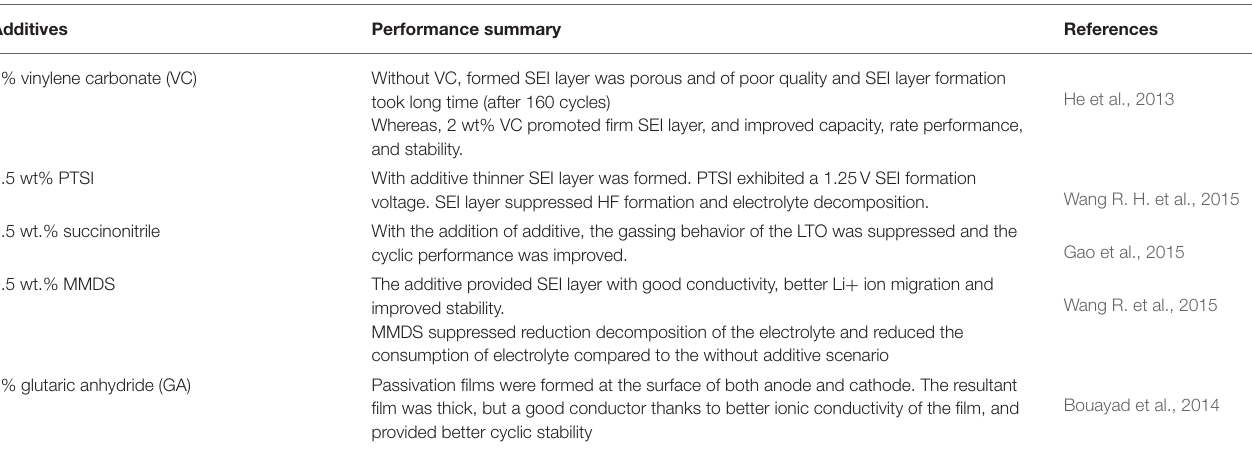
Section B: Additives, used in electrolytes, and corresponding performance summary Additives Performance